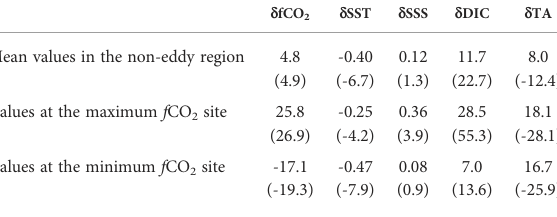
TABLE 2 Observed d f CO 2, d SST, d SSS, d DIC, and d TA in the non-eddy region, maximum and minimum f CO 2 sites. Calculated d f CO 2 from d SST, d SSS, d DIC, and d TA are shown in